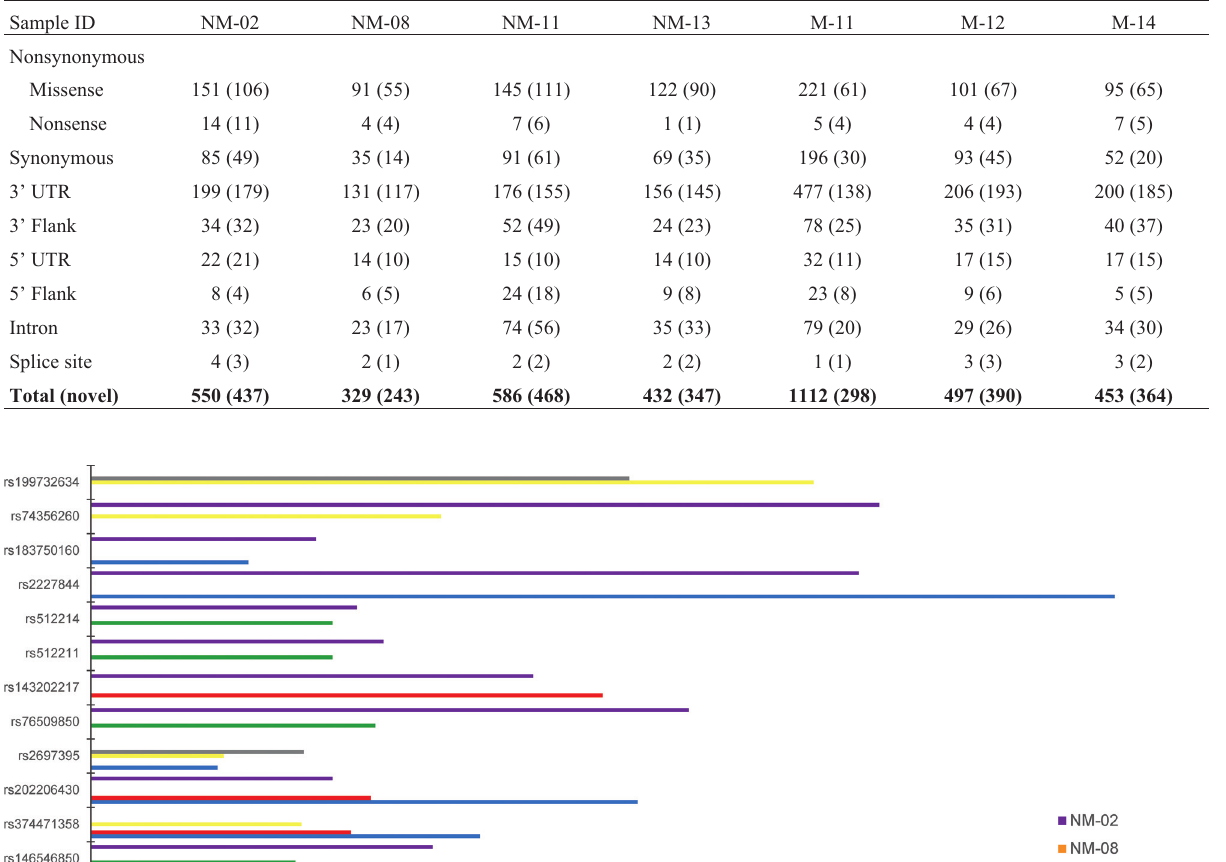
Table 4). The ASNS gene was found to have a synonymous mutation in three samples, and recurrent synonymous mu- tations were also observed in CHEK2 and DRD5 genes (Ta- ble 3). Splice site variants in FCGR2A (Fc Fragment of